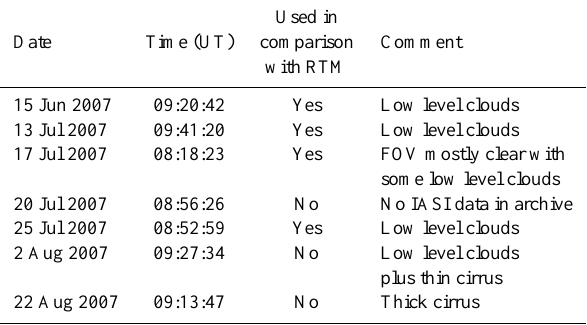
Fig. 2. Ascending trajectories of the four CFH sondes selected for comparison as shown in Table 1. The big brown cross is the launch location at the FMI Artic Research Centre observatory in Sodankyl¨a.